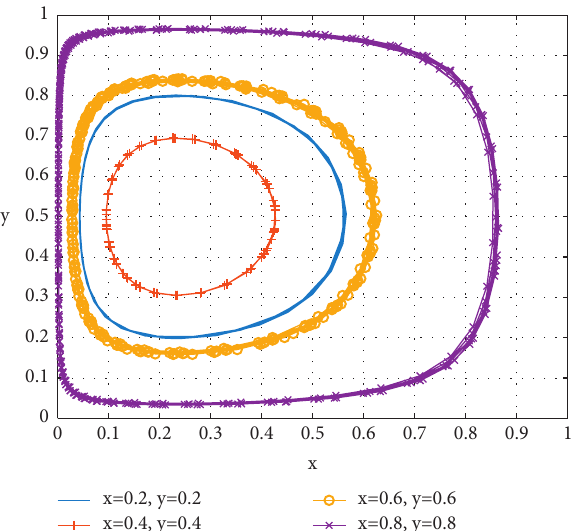
Figure 5: Simulation result of Case 5. Figure 6: Evolution results with the change of risk attitudes by the initial values in Case 1.